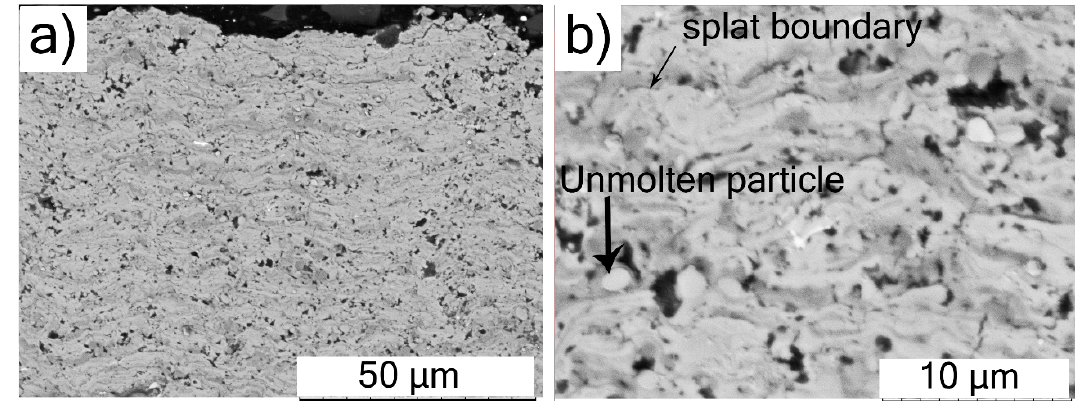
Figure 5. SEM micrographs of cross sections of SPS-deposited TiC coating: ( a ) low magnification; ( b ) high magnification.